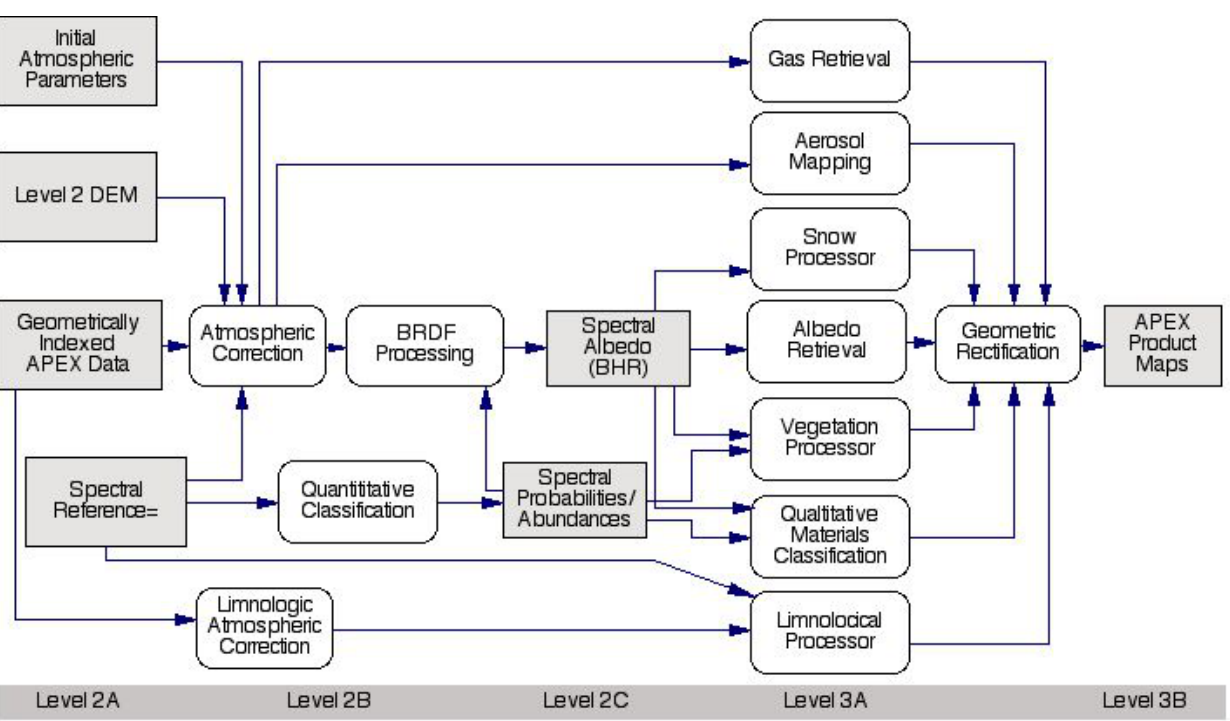
Figure 9. Level 2/3 APEX